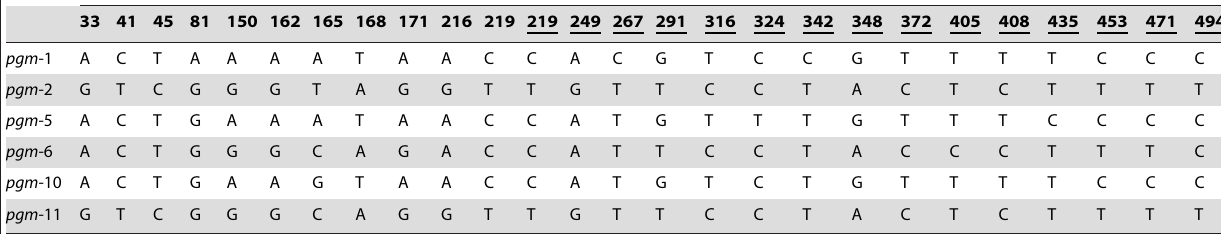
Table 7. SNPs in pgm locus